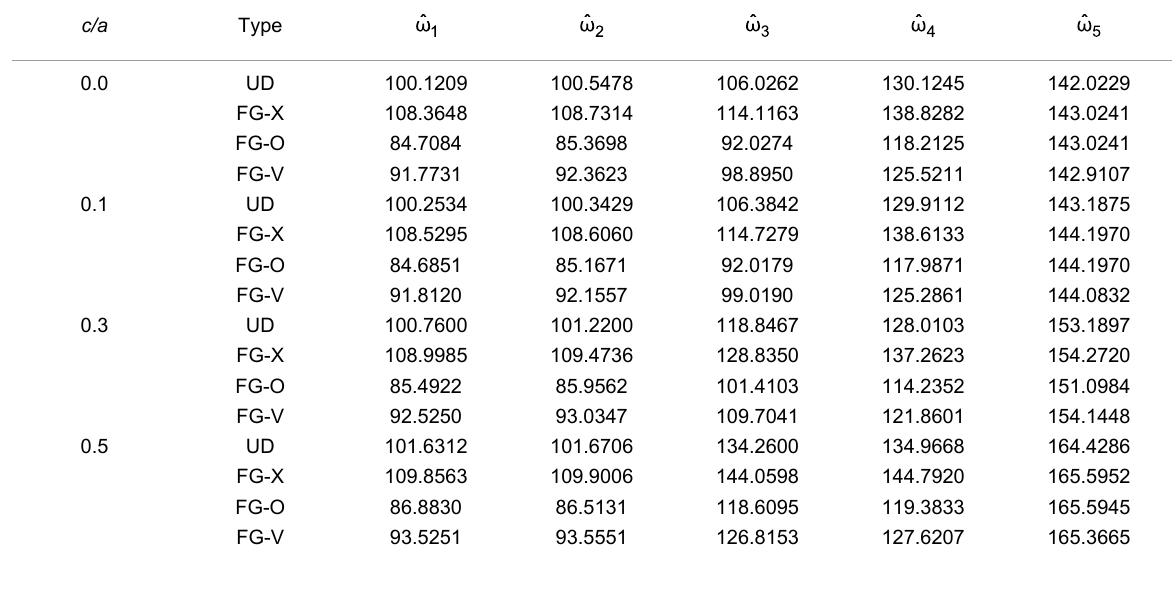
Table 11: First five natural frequency parameters for square, FG-CNTRC, CFCF plates with a centric cutout. Geometrical characteristics of the plate are a/b = 1, h/a = 0.05 with various c/a ratios. The volume fraction of CNTs is set equal to